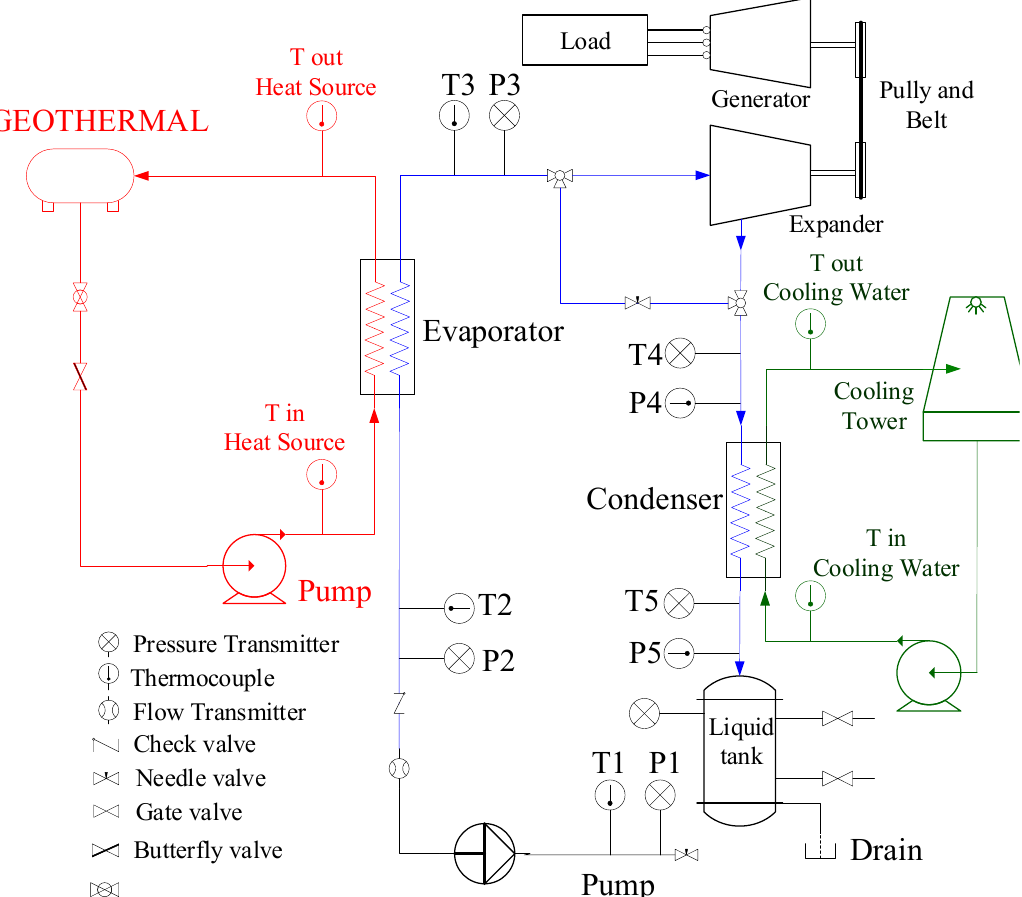
Figure 3. Flow diagram of an experimental ORC system.